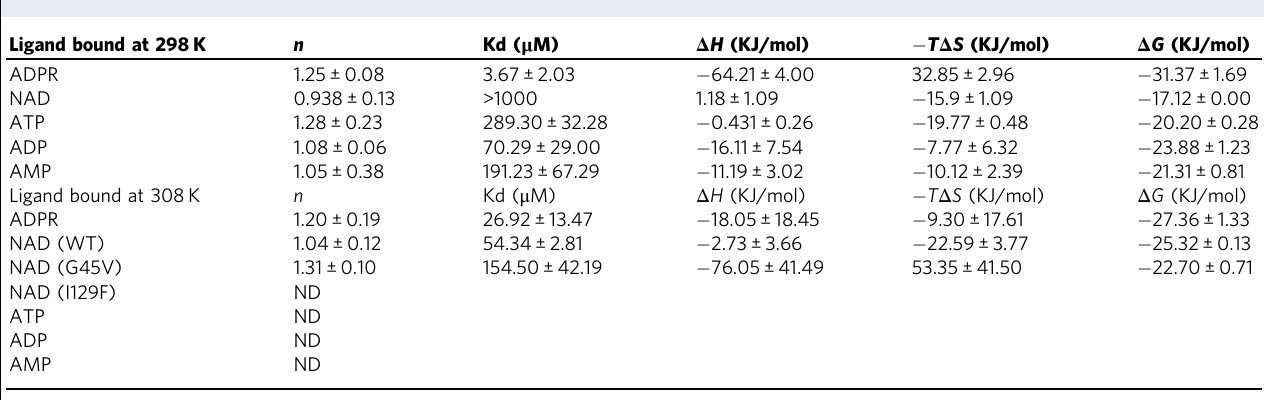
Table 3 ITC measurements of NAD metabolites bound to MERS-CoV macro